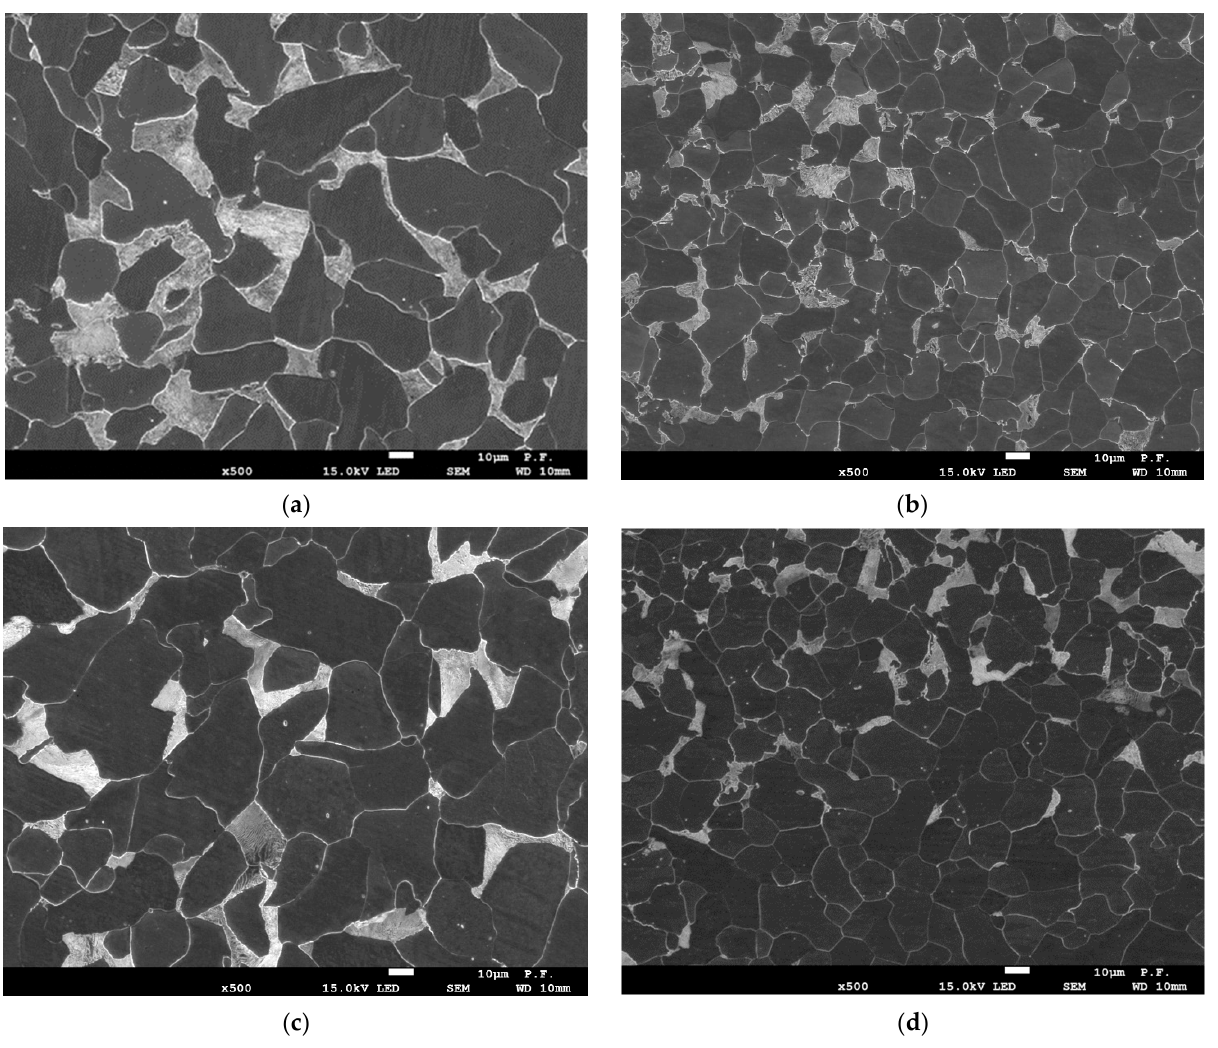
Figure 3. The SEM photographs of steel microstructure in longitudinal ( a , b ) and transverse direc- tions ( c , d ): ( a , c )—steel A; ( b , d )—steel B. tions ( c , d ): ( a , c )—steel A; ( b , d )—steel